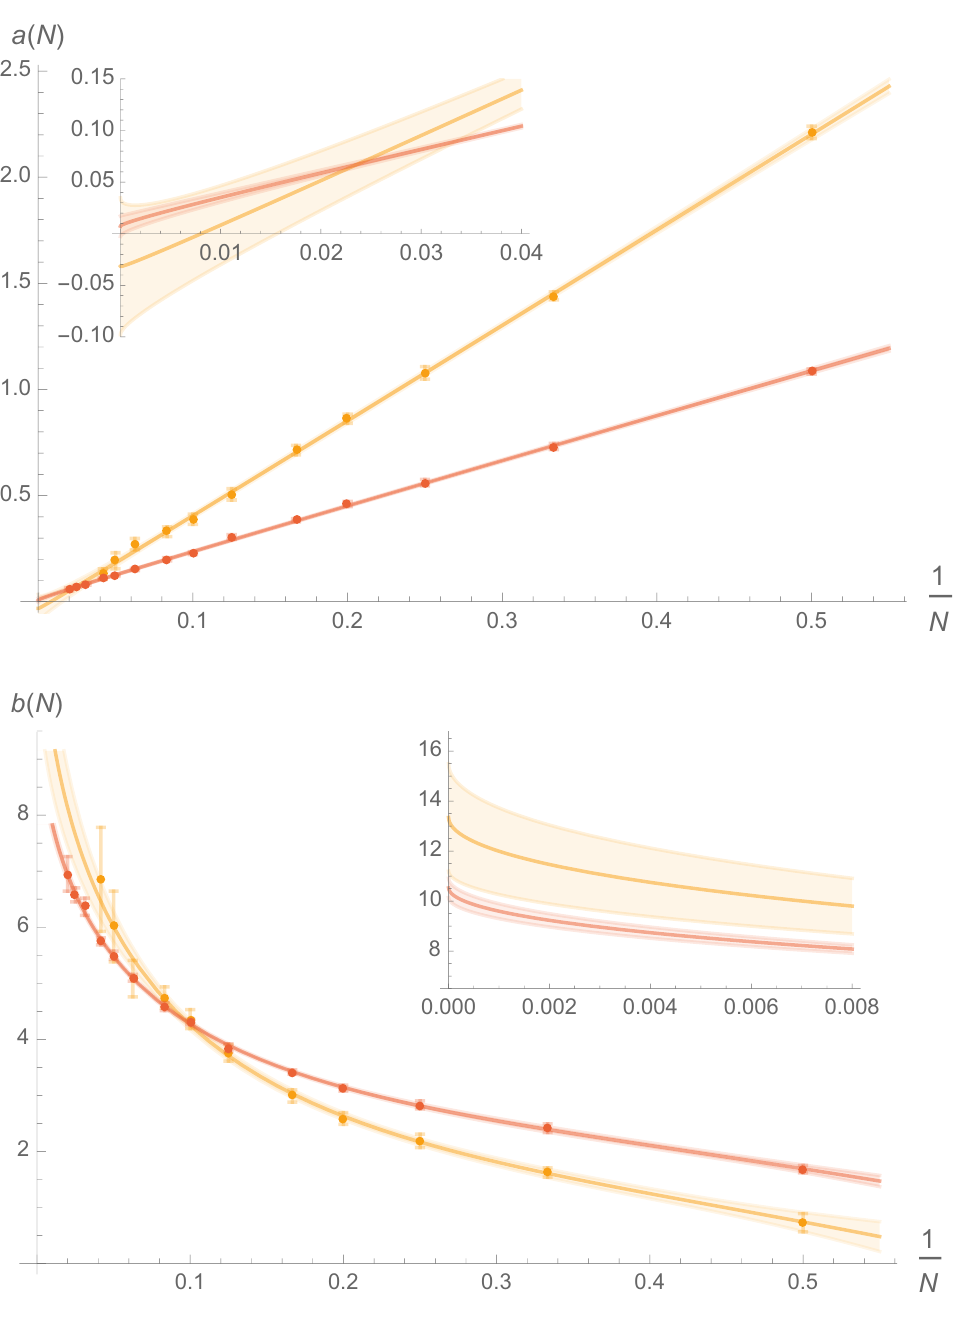
Figure 6 . a ( N ) and b ( N ) coefficients of the l→↑↑ transition line constructed from peaks in C (orange/larger errors) and χ (red/smaller errors) for N ≤ 50 . Pale-coloured stripes represent the 68% confidence intervals. The large N limits are zoomed-in. As we can see, the square root behaviour of the transition line, governed by a ( N ) , completely disappears in the infinite matrix limit, leaving only the linear